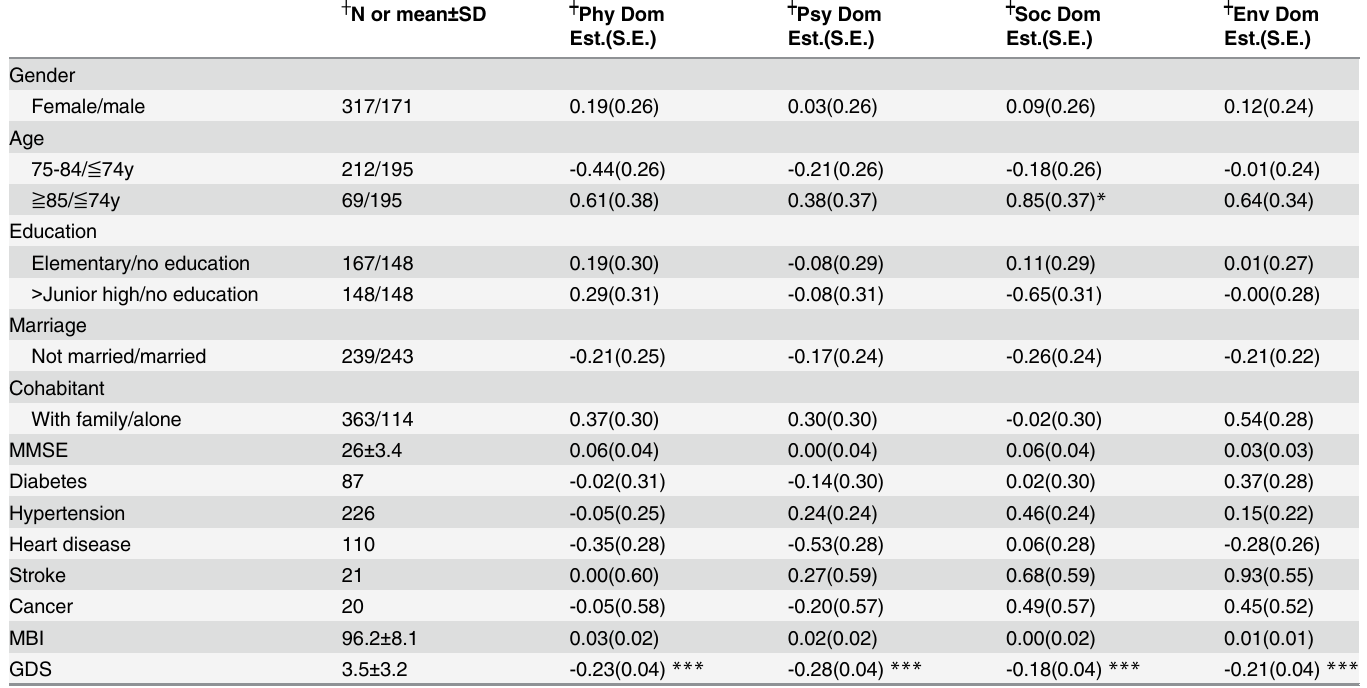
Table 1. Basic demographic and medical characteristics of participants and coefficients and standard errors (S.E.) of major determinants for WHOQOL-BREF domain scores under multiple linear regression models. ┼ N or mean ± SD ┿ Phy Dom ┿ Psy Dom ┿ Soc Dom ┿ Env Dom Est.(S.E.) Est.(S.E.) Est.(S.E.) Est.(S.E.) 0.19(0.26)